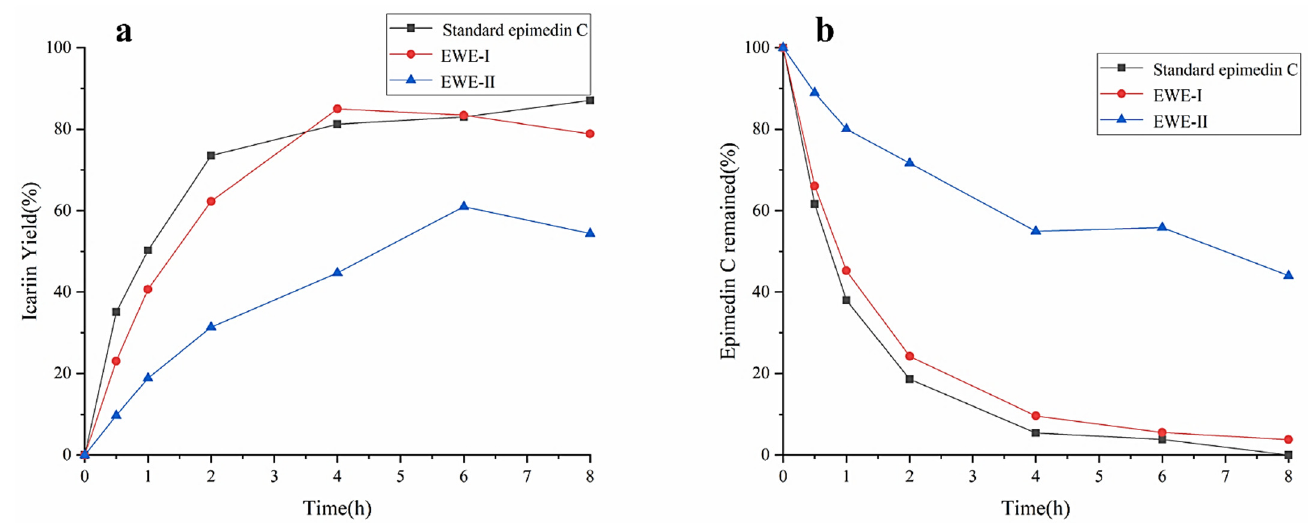
Figure 4. The effects of different purities of epimedin C on the yield of icariin ( a ) and epimedin C remaining ( b ).